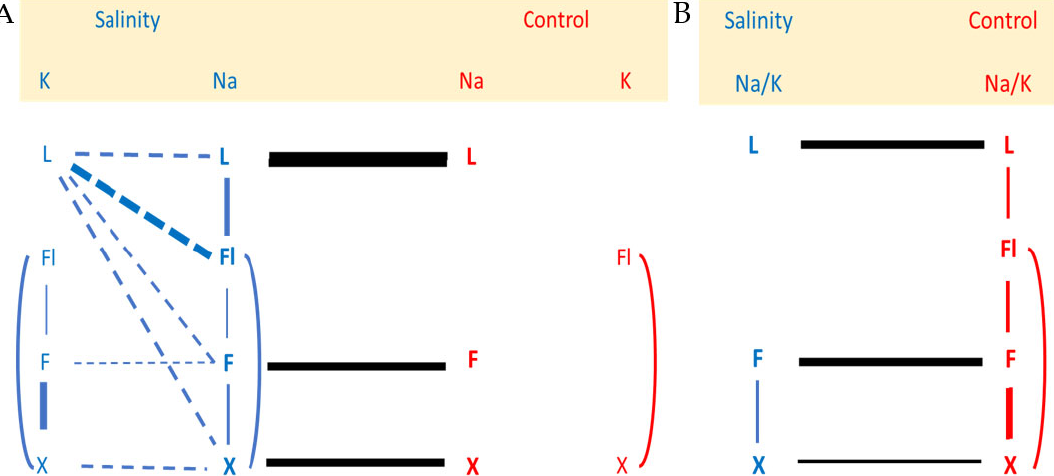
Figure 1. Schematic representation of significant ( p < 0.05) correlations by a continuous line (positive correlation), or a discontinuous line (negative correlation) connecting Na and K contents ( A ), and The Na/K ratio ( B ), of different organs (L: leaf, Fl: inflorescence, F: fruit, X: xylem sap). The thicker the line, the higher the correlation coefficient (see Table S1).